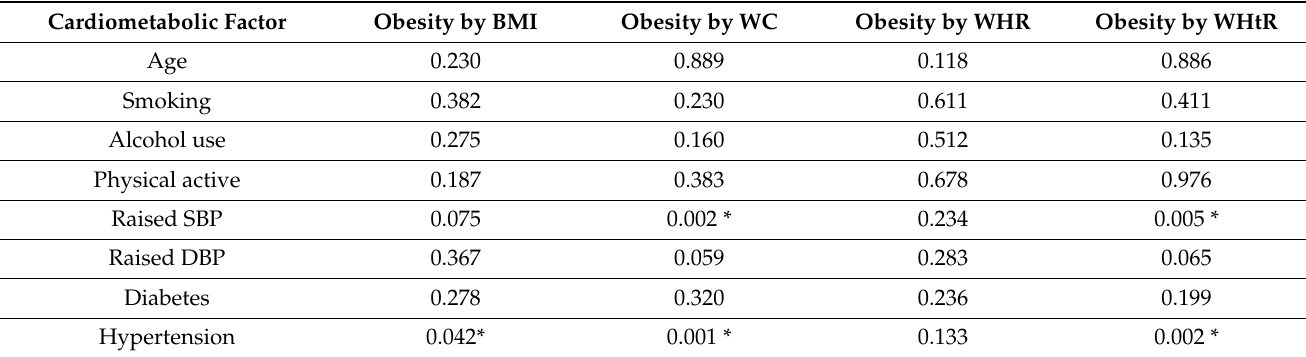
Table 3. Association between variables of cardio-metabolic and obesity (by BMI, WC, WHR and WHtR) amongst male truck drivers.